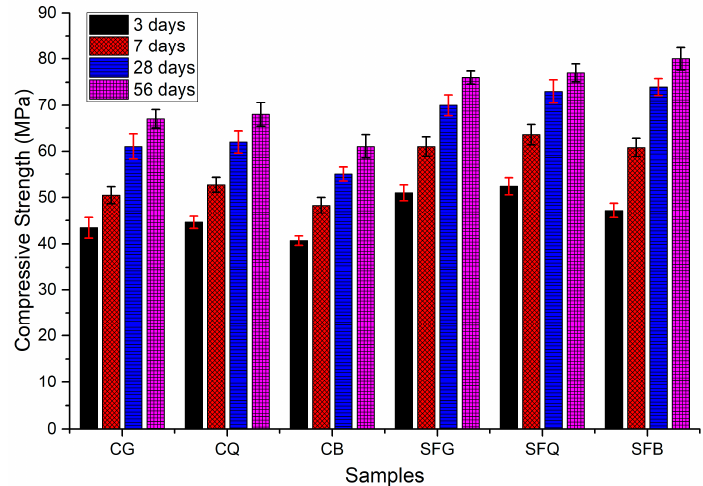
Figure 2. Compressive strength test results.